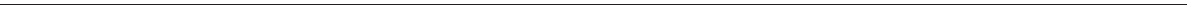
FIGURE 1 | (C) Phylogenetic overview of maximum recorded lifespan, genome size, and repeat content in a uniform presentation. The branch lengths are proportional to the geological times based on information retrieved from the Timetree of Life website (http://www.timetree.org/). The lifespan of the coelacanth was suggested to be over 100 years in other literature (Froese and Palomares, 2000). Repetitiveness in the genomes was quantified uniformly as previously described (Hara et al., 2018). The genome sizes are based on flow cytometry except for the human for which a total length of the genome sequences (3.2 Gbp) is conventionally referred to as its genome size (*). Because the documented lifespan of the brownbanded bamboo shark, Chiloscyllium punctatum is unavailable, that of a different species in the same genus ( C. plagiosum ) is included. The numbers in parentheses correspond to the following publications: (1) Allard et al. (1998); (2) Morton